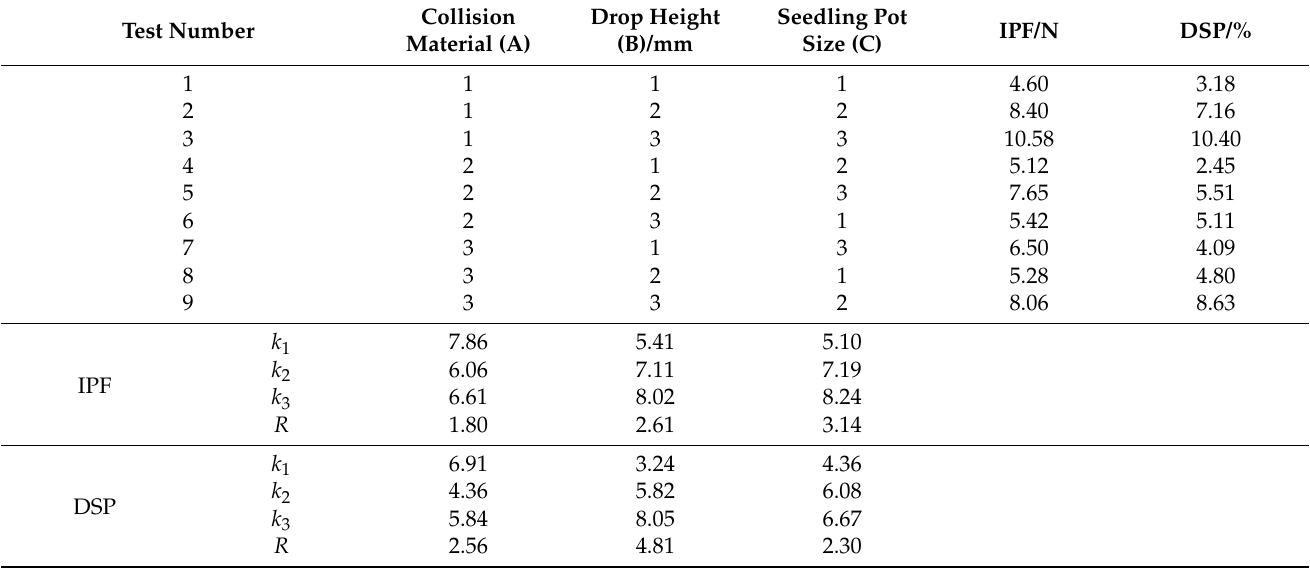
Table 3. Experimental arrangement and